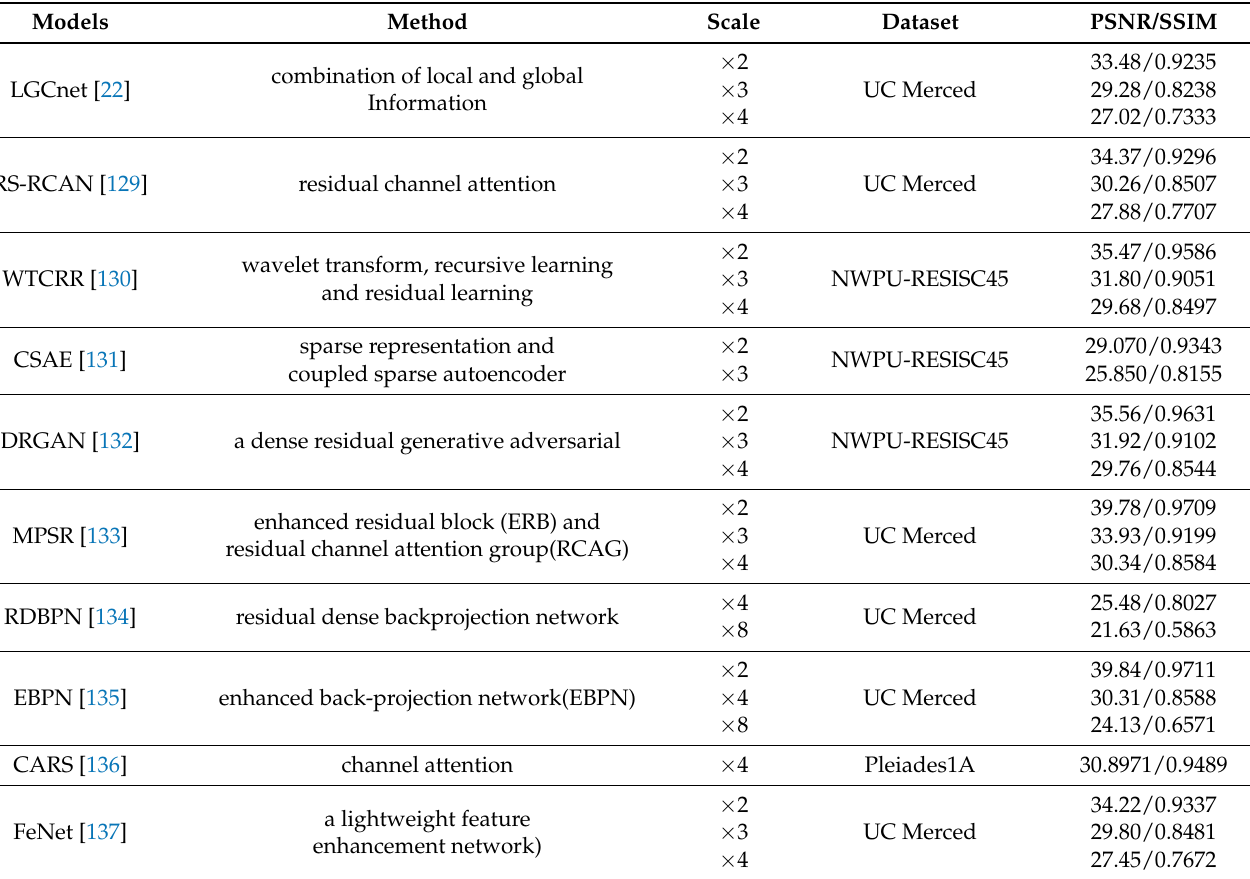
Table 3. PSNR/SSIM of some representative methods for remote sensing image